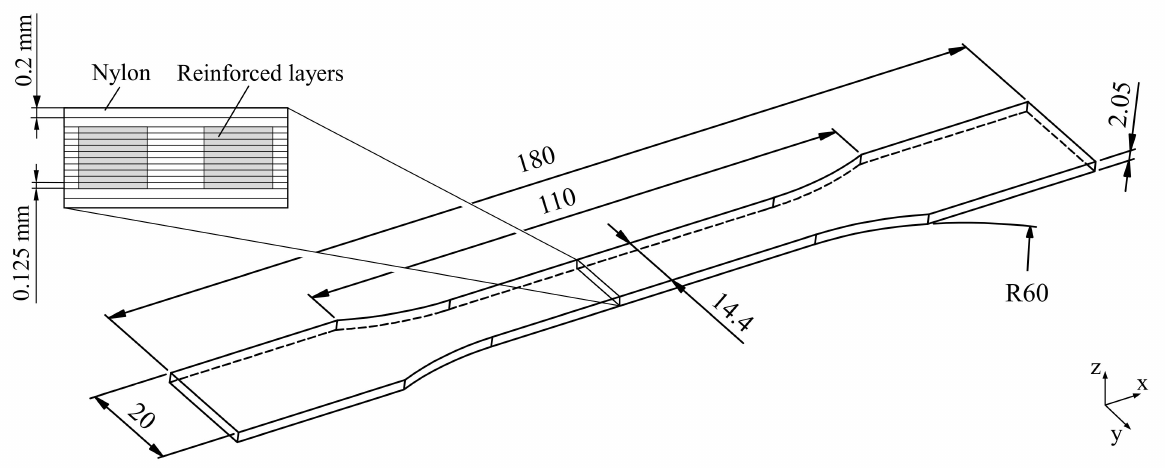
Figure 3. Dimensions of the tensile specimen with the schematic layer